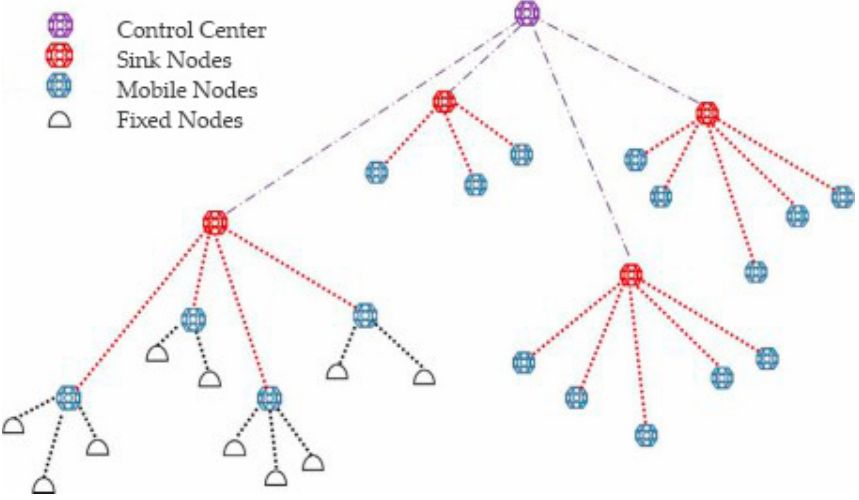
Figure 1. Network topology.